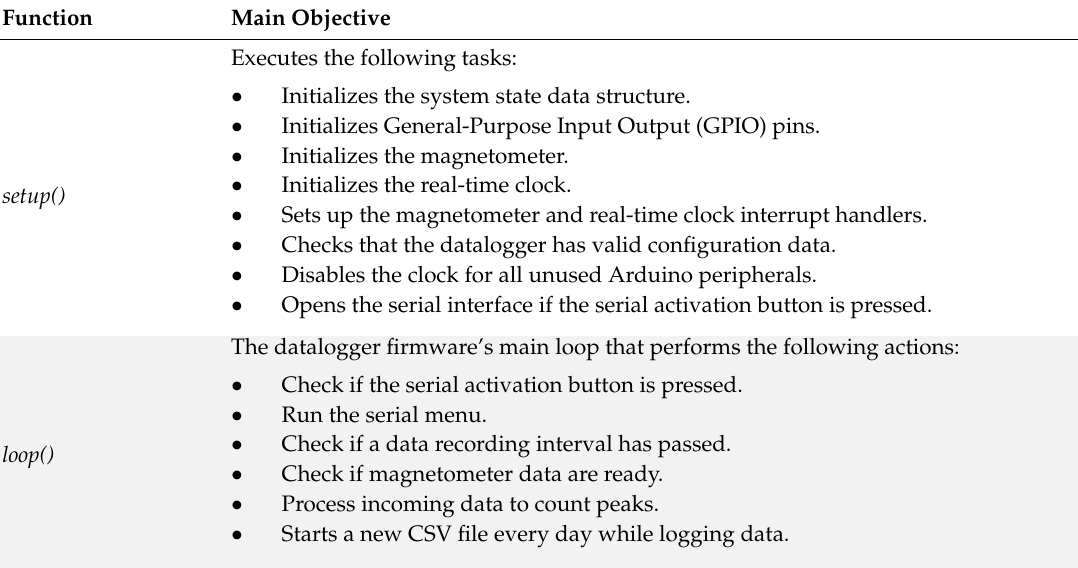
Table 3. Functions executed by the CIWS datalogger Firmware.ino file and main